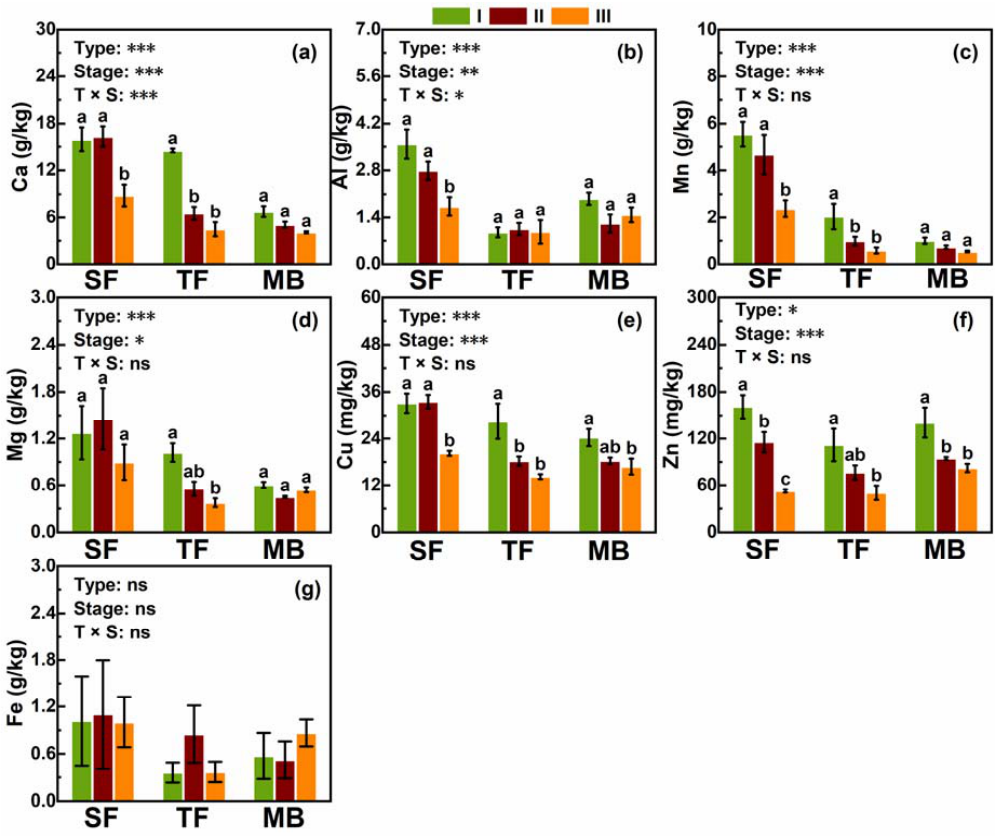
Figure 2. Concentrations of meso- and micro-elements at the three stages of litter decomposition (I, II, and III) in the three forest types. ( a – g) a–g, in turn, is the concentration of Ca, Al, Mn, Mg, Cu, Zn, and Fe in the litter. The codes for forest types are described as in Figure 1. Mean, SE ( n = 9), and the significance levels ( *** p < 0.001, ** p < 0.01, * p < 0.05, and ns p > 0.05) of two ‐ way ANOVAs are also given. Different letters indicate significant differences between the four stages within a forest type.